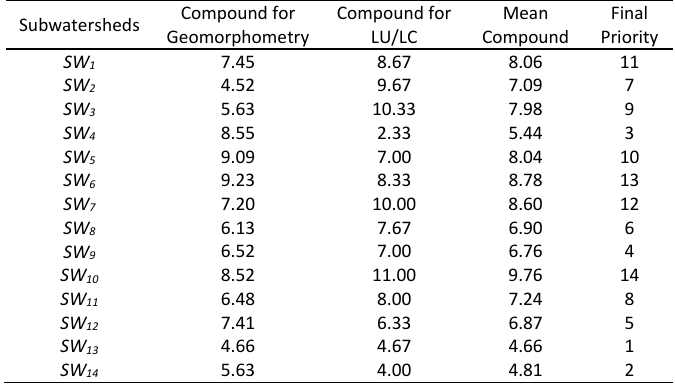
Fig. 4: Land use/land cover map of subwatersheds Fig. 4. Land use/land cover map of subwatersheds Fig. 5: Priority index map of subwatersheds Fig. 5. Priority index map of Table 8: Final priority values of subwatersheds Table 8. Final priority values of subwatersheds